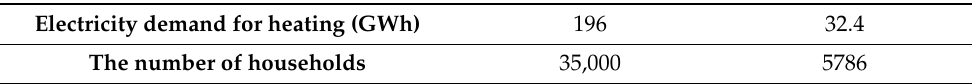
Table 12. Electricity demand for heating during 150 days (GWh) depending on the number of households and the floating solar power plant electricity production. Electricity demand for heating